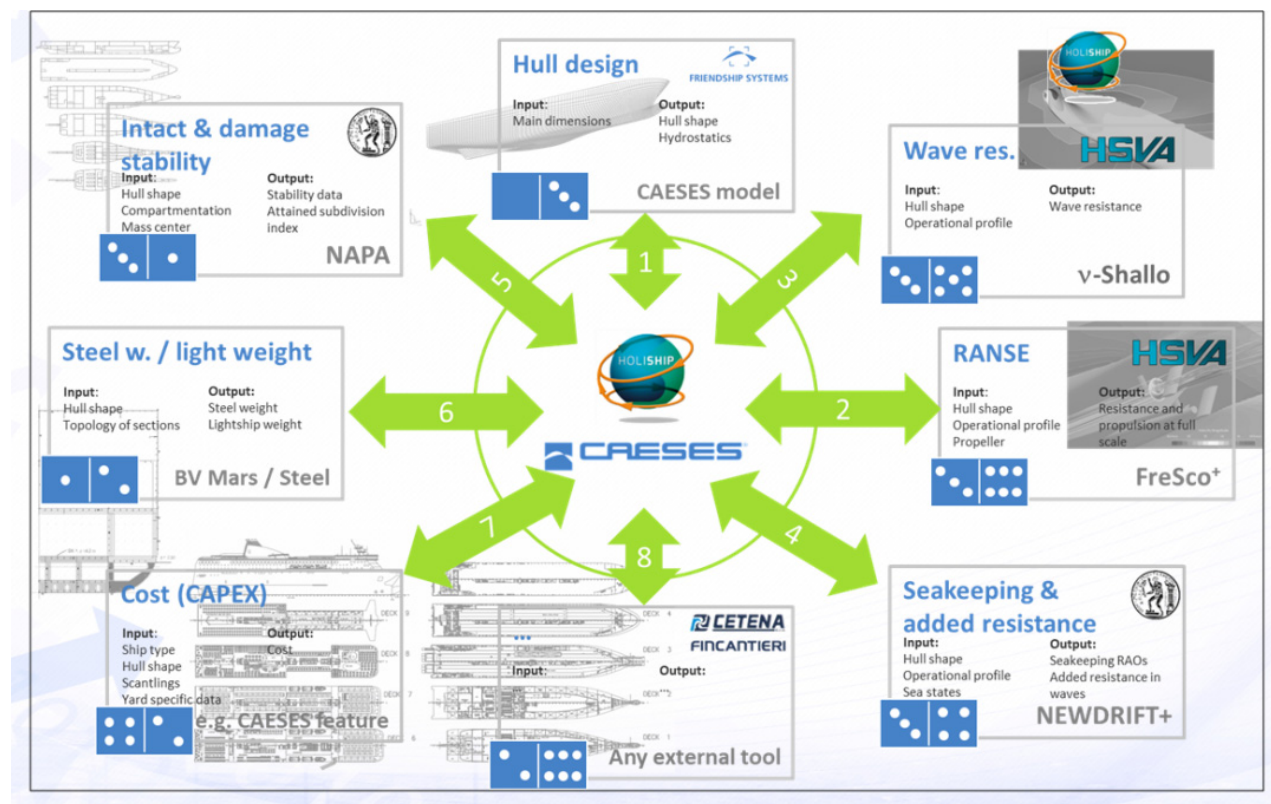
Figure 11. CAESES ® /Friendship Systems Synthesis of Tools for RoPax Parametric Design Optimiza- tion.